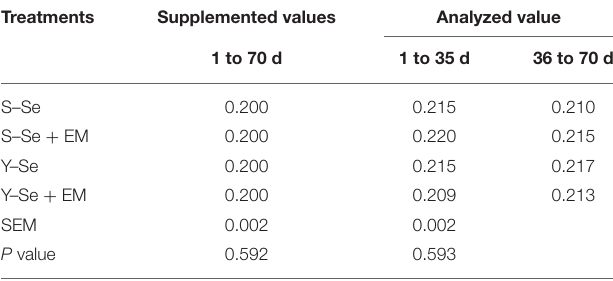
TABLE 2 | Concentration of Se in experimental diets